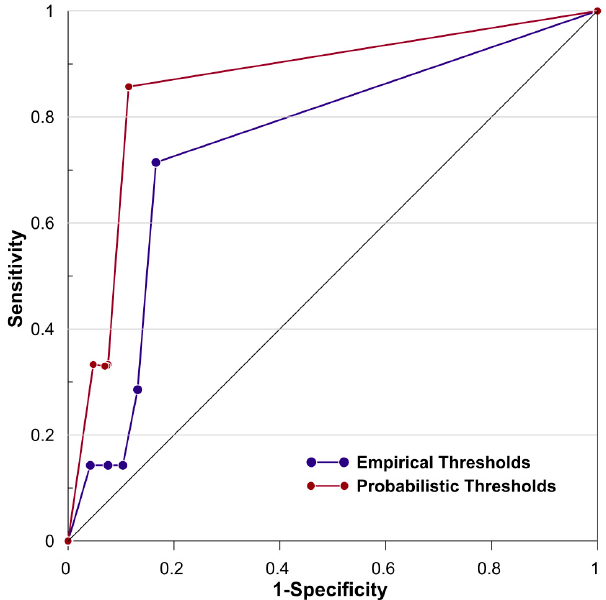
Figure 7. Receiver operating characteristic (ROC) curves for the derived thresholds.